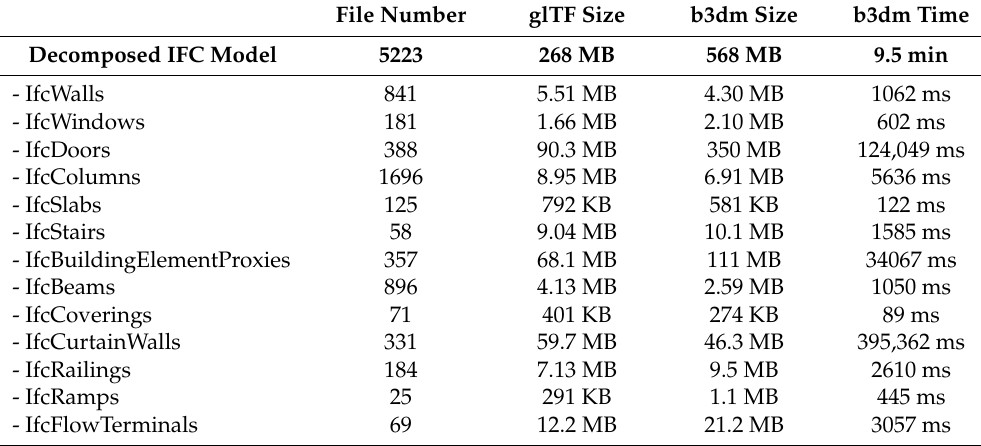
Table 4. Intermediate disk usage and processing time for each IFC types during the OBJ to glTF and glTF to b3dm steps.